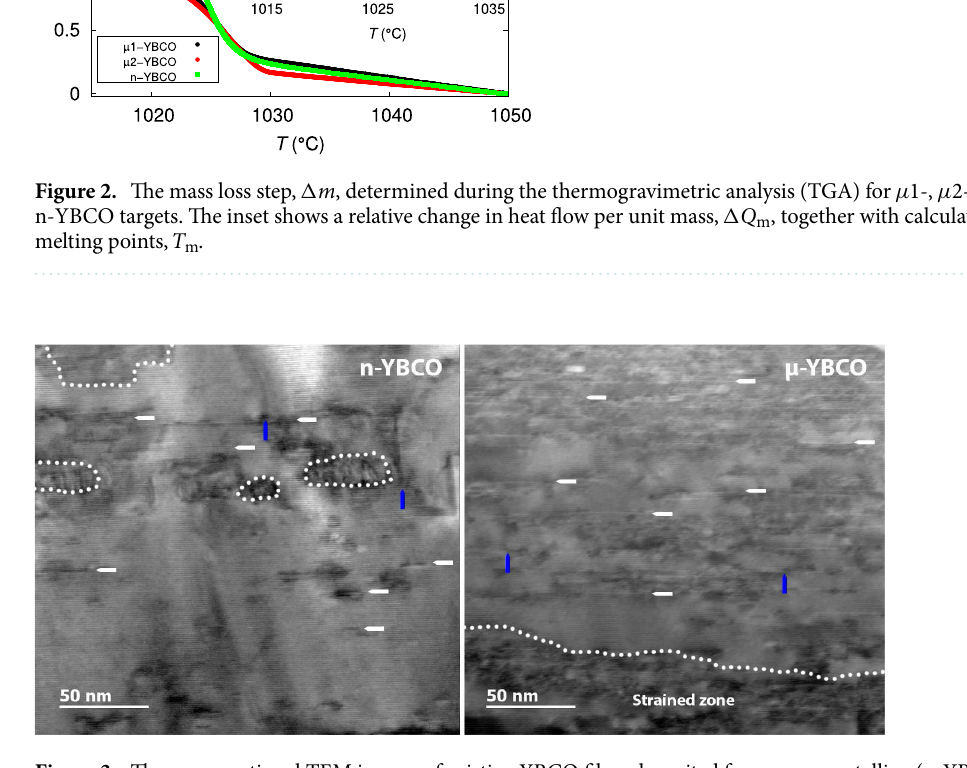
Figure 3. The cross-sectional TEM images of pristine YBCO films deposited from nanocrystalline (n-YBCO) and microcrystalline ( µ 1-YBCO) targets. White arrows indicate the stacking faults along the ab -plane and blue arrows the basal dislocations. The strained zones with Y248 intergrowths are bordered by the dotted